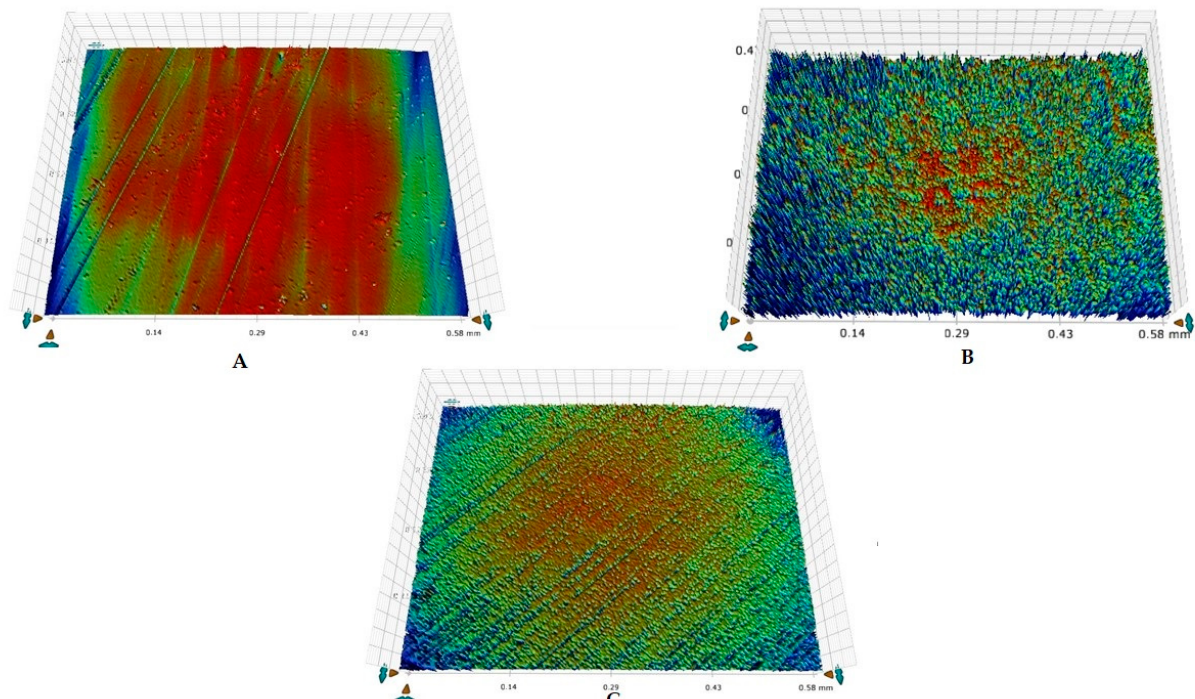
Figure 3. Representative enamel surface roughness profilometric images belonging to group 2 showing: ( A ) ground and polished enamel surface at baseline, ( B ) rough enamel surface post-demineralization, ( C ) remineralized enamel surface after brushing.